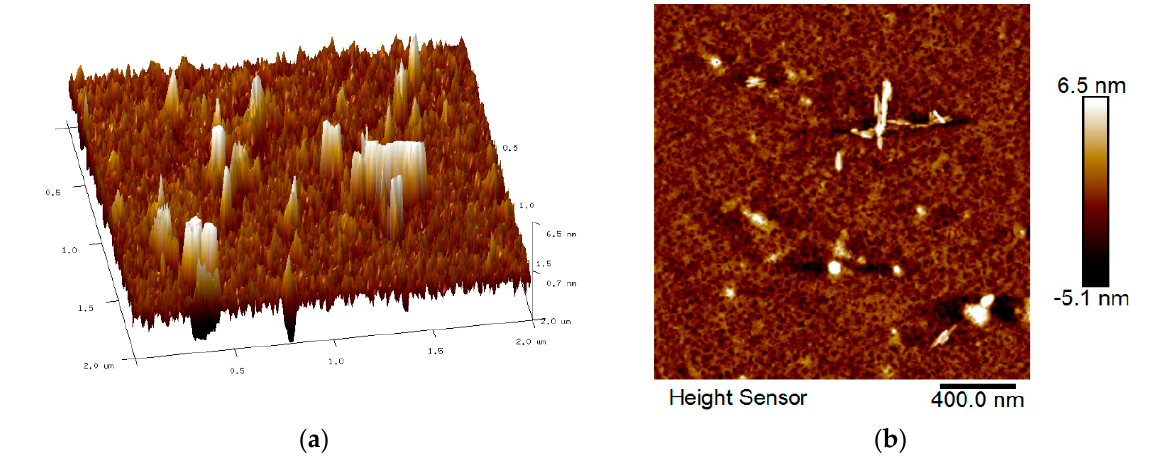
Figure 8. AFM images of GQDs − PVA thin film after contact with carbaryl: ( a ) 3D image and ( b ) 2D image.